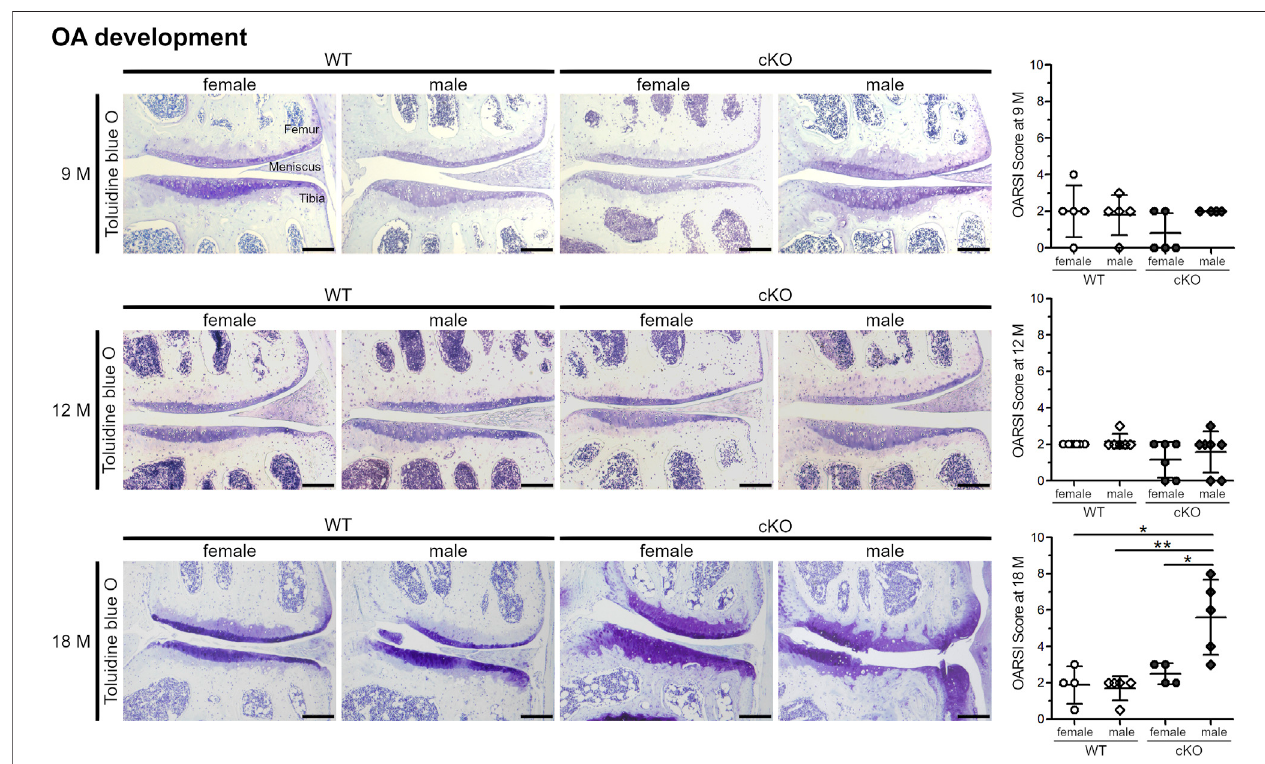
FIGURE 5 | Male ERp57cKO mice develop strong signs of OA during ageing. At the age of 18 months, OARSI scoring of toluidine blue O-stained knee sections reveals an increase of cartilage degradation, including osteophyte formation in male cKO mice, but not in female cKO mice ( p = 0.0241313), nor female WT ( p = 0.01398420)ormaleWTmice( p =0.00394253).Atearliertimepoints(9and12 M),nodifferencebetweenthesexesorgenotypesisobserved.ScaleBar=100 μ m,M=